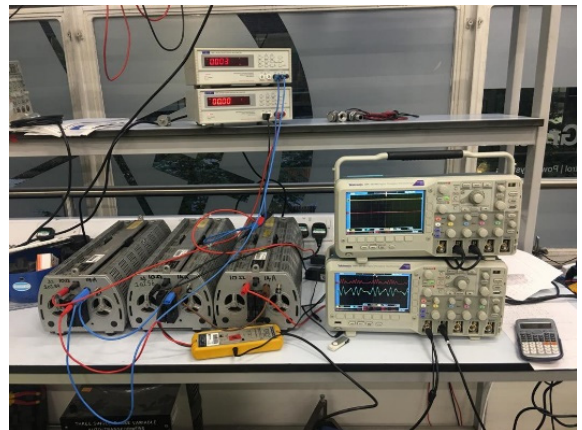
Figure 26. Resistive load tests measurement setup.